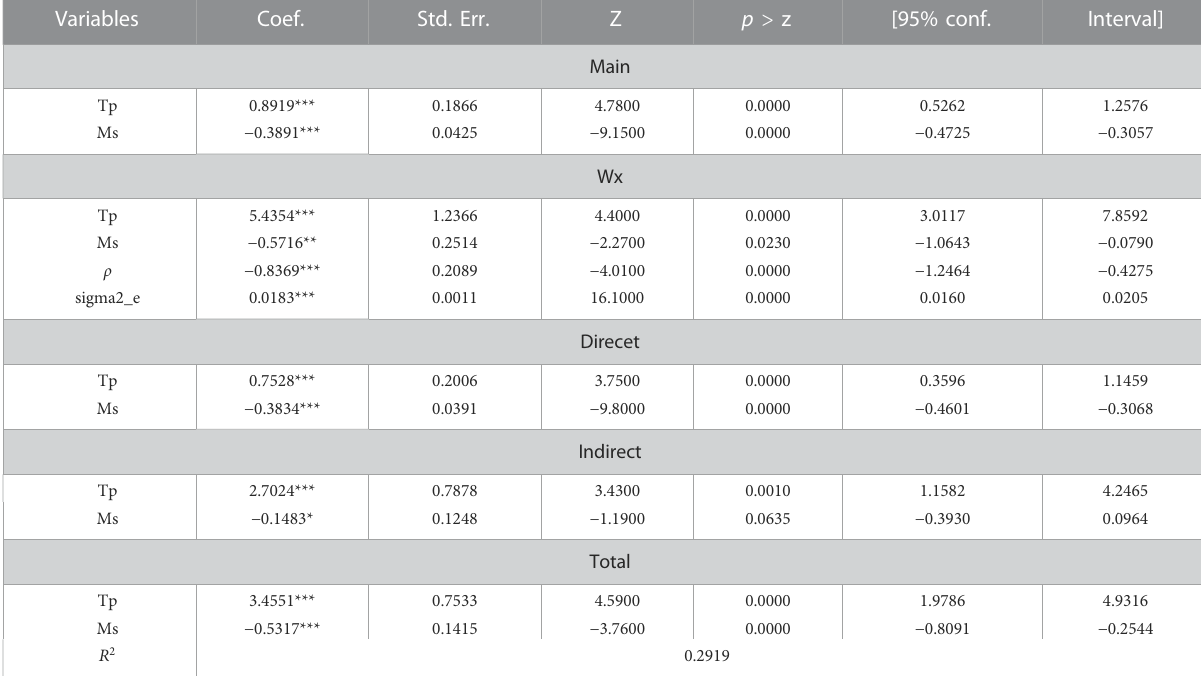
TABLE 9 Regression results of general spatial panel model. Variables Coef.